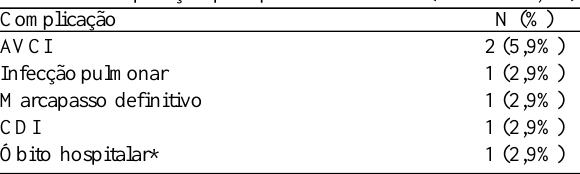
Tabela 3. Complicações pós-operatórias imediatas (n = 5/34 - 14,7%).